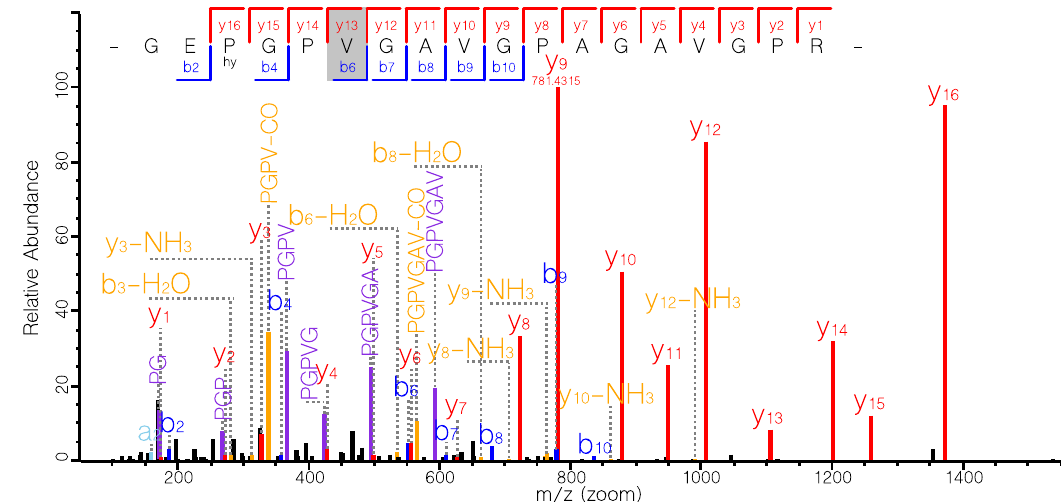
Figure 4. LC–MS/MS spectra for caprine specific peptide GEPGPVGAVGPAGAVGPR in sample P4859C from Spoegrivier, South Africa, morphologically assigned to sheep. The corresponding peptide for springbok, grey rhebok, grey duiker was not detected. Hy on y16 indicates the presence of hydroxyproline, greyed out V is indicative of species-specific amino